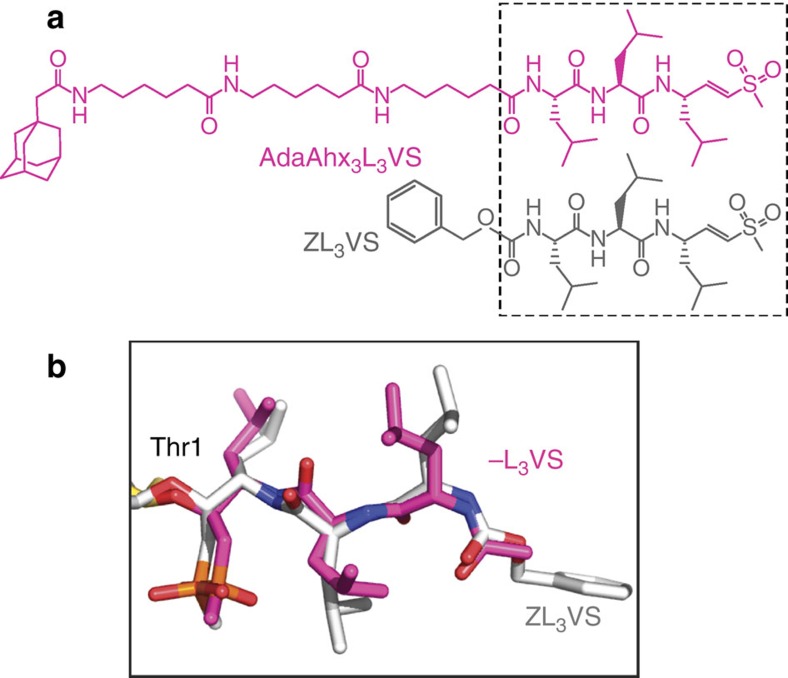
Conformations of the -L3VS moiety of AdaAhx3L3VS and ZL3VS bound to the 20S proteasome core.(a) Structural formulae of AdaAhx3L3VS and ZL3VS with their -L3VS moiety boxed. (b) The -L3VS moiety of the AdaAhx3L3VS molecule (in magenta) at the human 20S proteasome core β5 subunit active site is shown with superimposed coordinates for ZL3VS (grey), as found in a yeast 20S proteasome core crystallographic structure19.